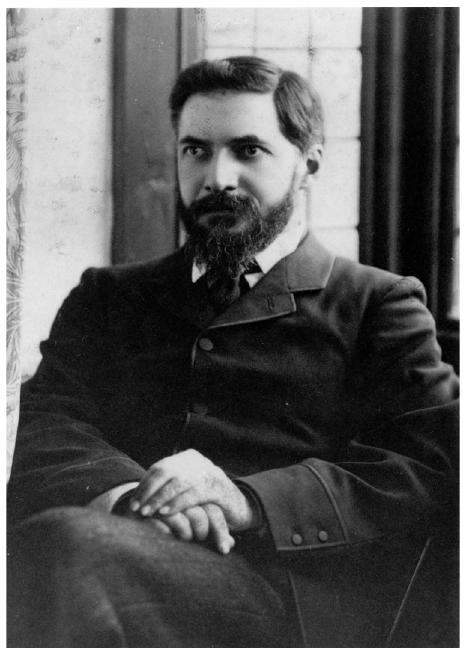
Fig. 1: William Flinders Petrie